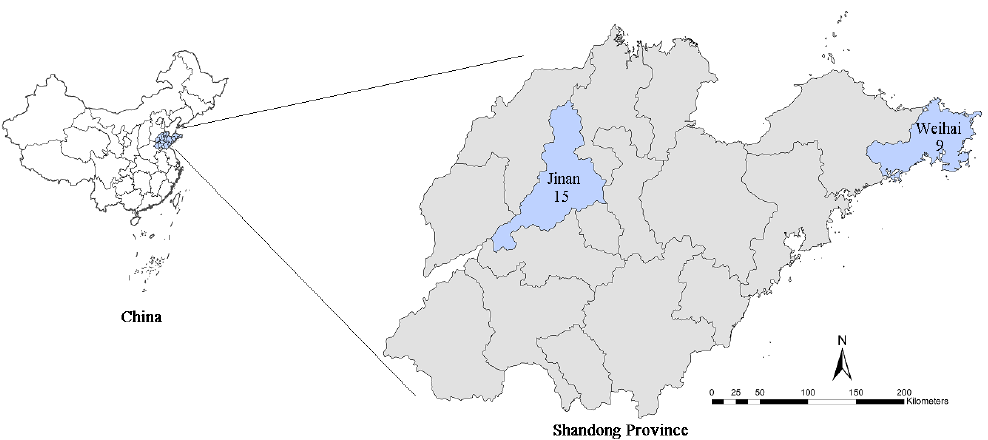
Figure 1. The location of Jinan and Weihai in the Shandong Province; the two cities are shown in blue. The numbers represent the number of air quality monitoring stations in each city.